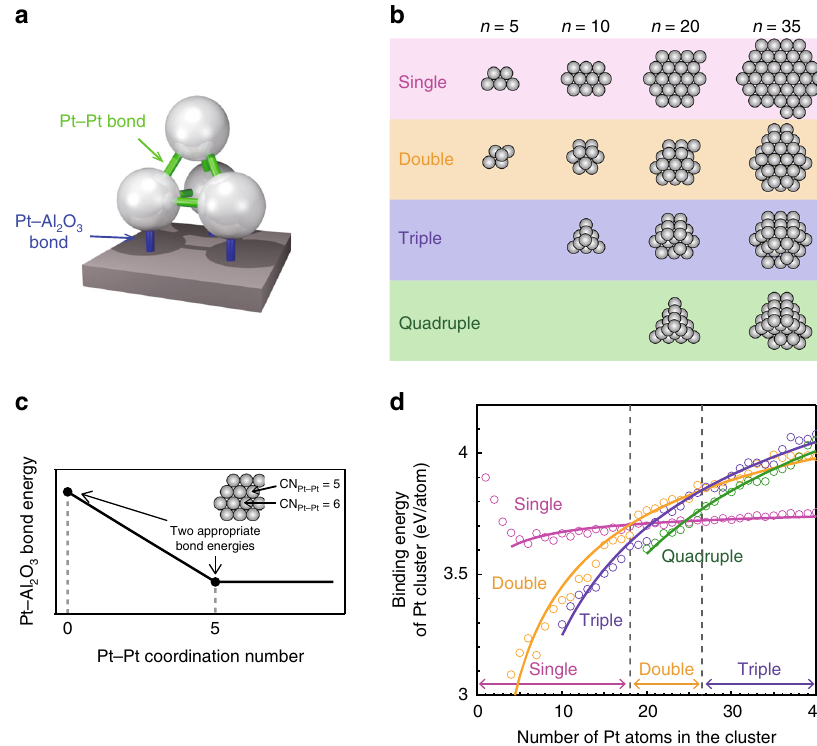
Fig. 4 Simulation of cluster morphologies using the bond-additivity model. a Schematic illustration of a double-layer Pt 4 cluster. The Pt – Pt and Pt – Al 2 O 3 bonds are represented using green and blue lines, respectively. b Top view of the models for Pt n structures for which binding energies were calculated using the bond-additivity model (BAM). The numbers of Pt – Pt and Pt – Al 2 O 3 bonds were counted based on these model structures. c Schematic illustration of the Pt – Al 2 O 3 bond energy as a function of the Pt – Pt coordination number, which was used to calculate the binding energies of the Pt n clusters using the BAM. The arrows indicate the bond energies at CN Pt – Pt = 0 and 5, which were used to calculate the slope and intercept of the linear function. d Binding energies of Pt n clusters with single, double, triple, and quadruple layer (represented by pink, orange, blue, and green circles, respectively) calculated using the BAM as a function of cluster size. The two vertical dashed lines show the simulated sizes corresponding to morphological transitions from single to double layers ( n = 18 – 19) and from double to triple layers ( n = 26 – 27). Source data are provided as a Source Data fi